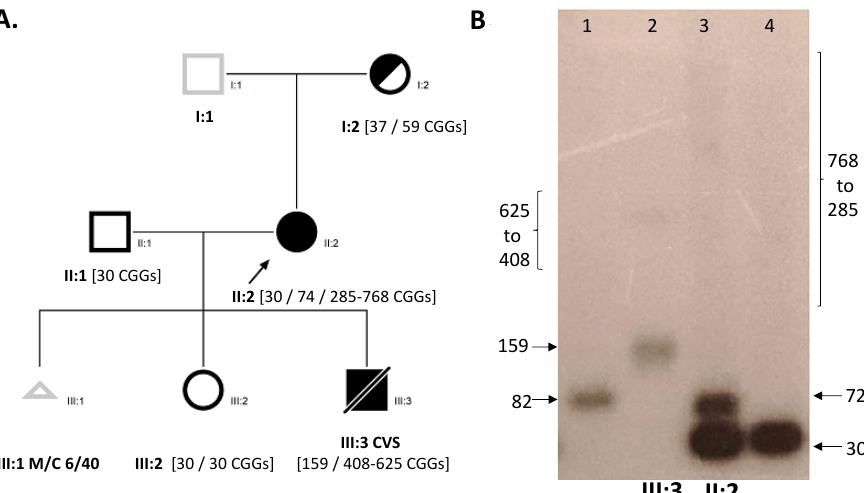
Figure 2. ( A ) Pedigree of the studied family with CGG sizing determined using Southern blot and standard CGG sizing PCR. Males are represented by squares, females by circles and triangle sex unknown. The black outline indicates examined, half shaded indicates carrier, and full shaded indicates affected with FXS. The black arrows indicate proband and a diagonal line indicates being deceased. III:1 Miscarriage at 6 of 40 weeks ( B ) Southern blot Lane 1 (male PM control), Lane 2 (III:3 male PM/FM CVS), Lane 3 (II:2 PM/FM female), Lane 4 (male normal CGG size control).